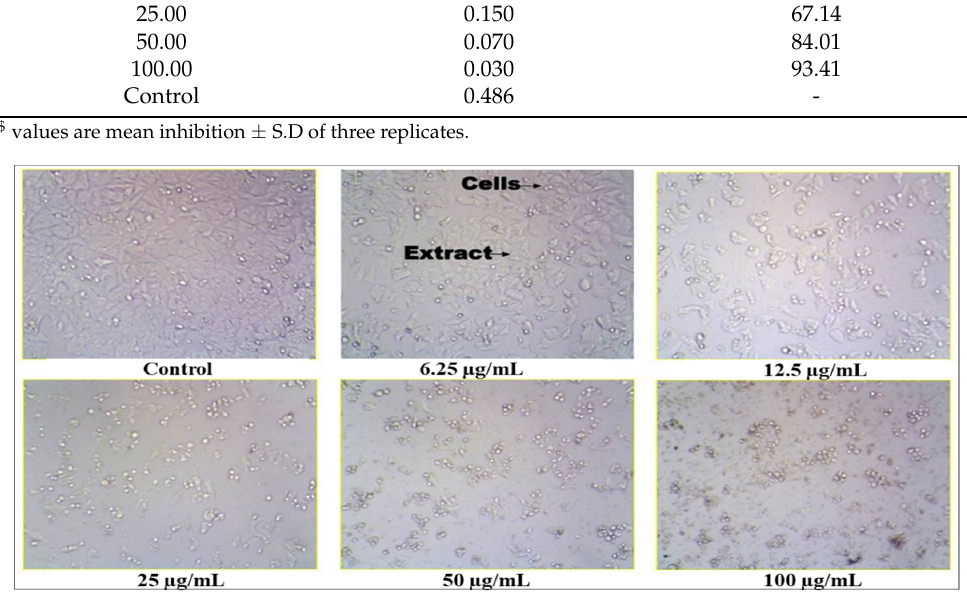
Figure 7. Anticancer activity of Simarouba glauca extract on MCF-7 cell line.